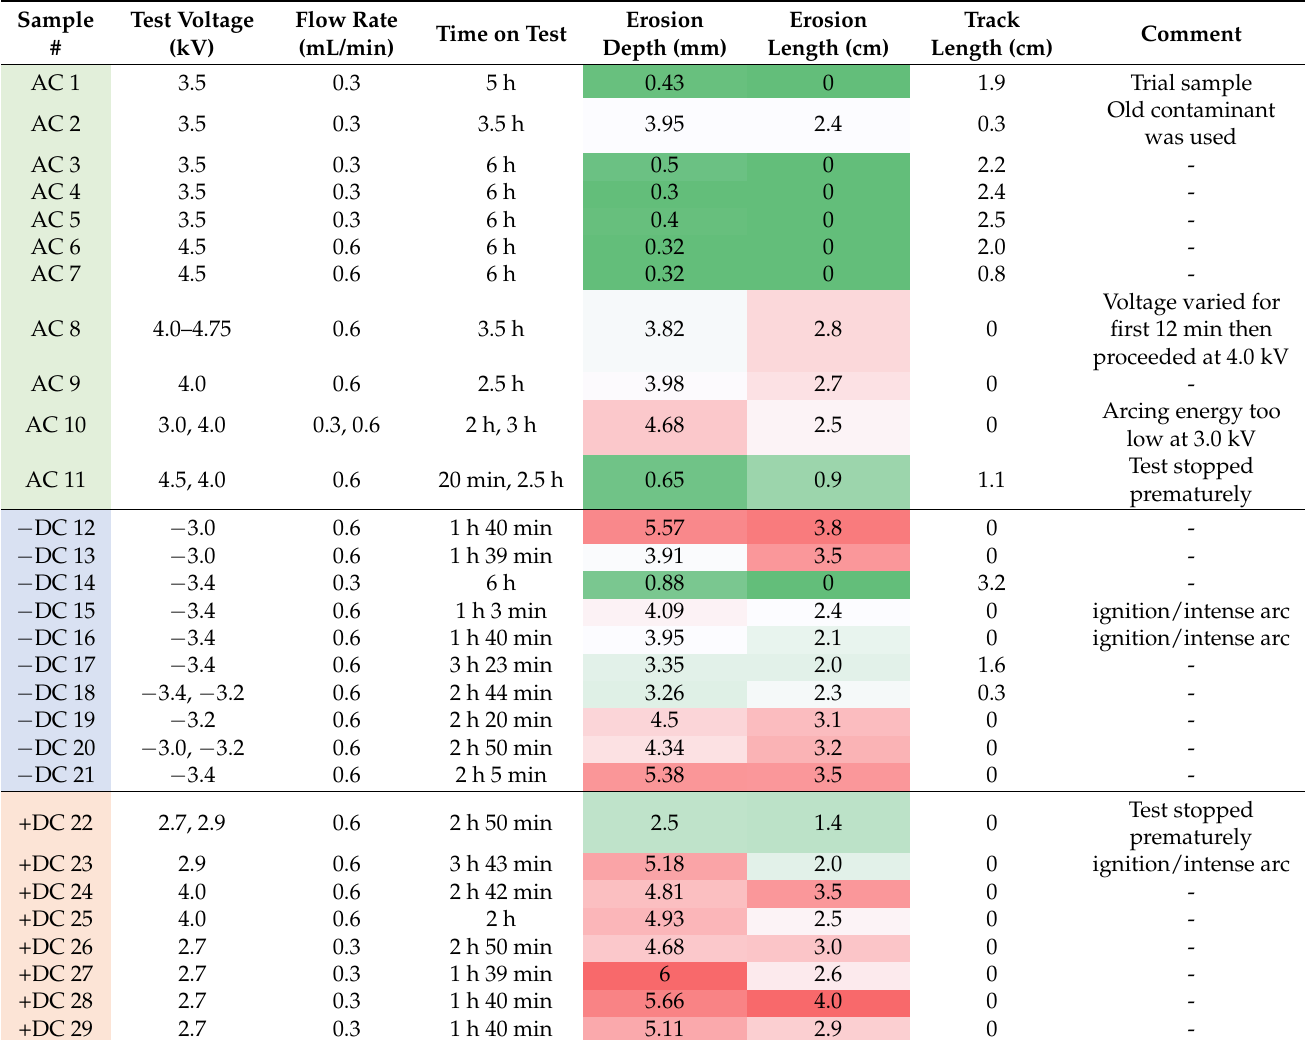
Table A1. Results of evaluation of test parameters and comparison of material damage at AC, − DC, and + DC voltages; green cells lie within the lower range of erosion damage, white cells are within the middle range, and red cells are within the higher